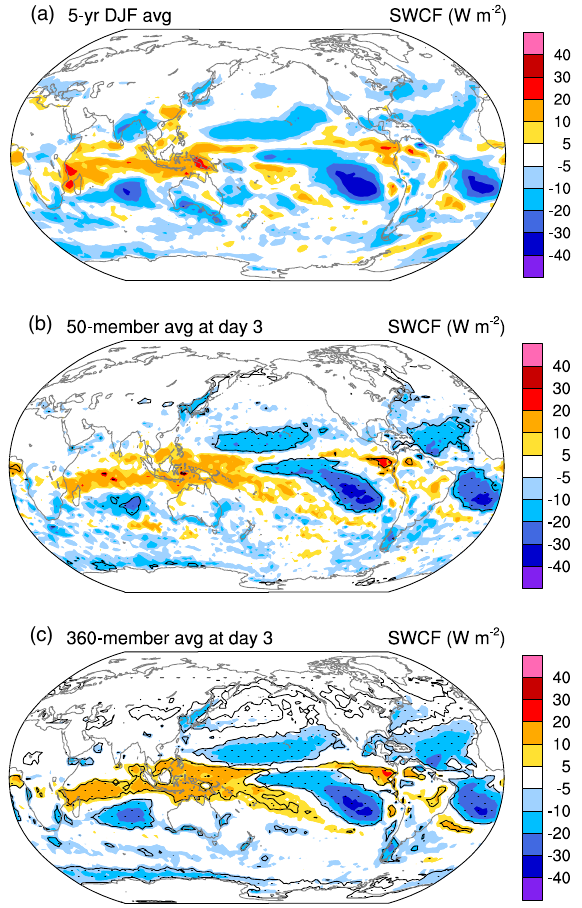
Figure 6. Shortwave cloud forcing differences (unit: W m − 2 ) be- Fig. 6. Shortwave cloud forcing differences (unit: Wm − 2 ) between tween simulations using 4 and 30min time steps. (a) 5-year DJF simulations using 4 min and 30 min time steps. (a) 5 yr DJF av- average from a climate simulation performed in the traditional way; erage from a climate simulation performed in the traditional way; (b) day-3 average from ensemble simulations with 50 independent (b) day 3 average from ensemble simulations with 50 independent members; (c) day-3 average from ensemble simulations with 360 members; (c) day 3 average from ensemble simulations with 360 independent members. In panels (b) and (c) , stippled regions are independent members. In panels (b) and (c) , stippled regions are associated with differences significant at the 95% confidence level. associated with differences significant at the 95 % confidence level.